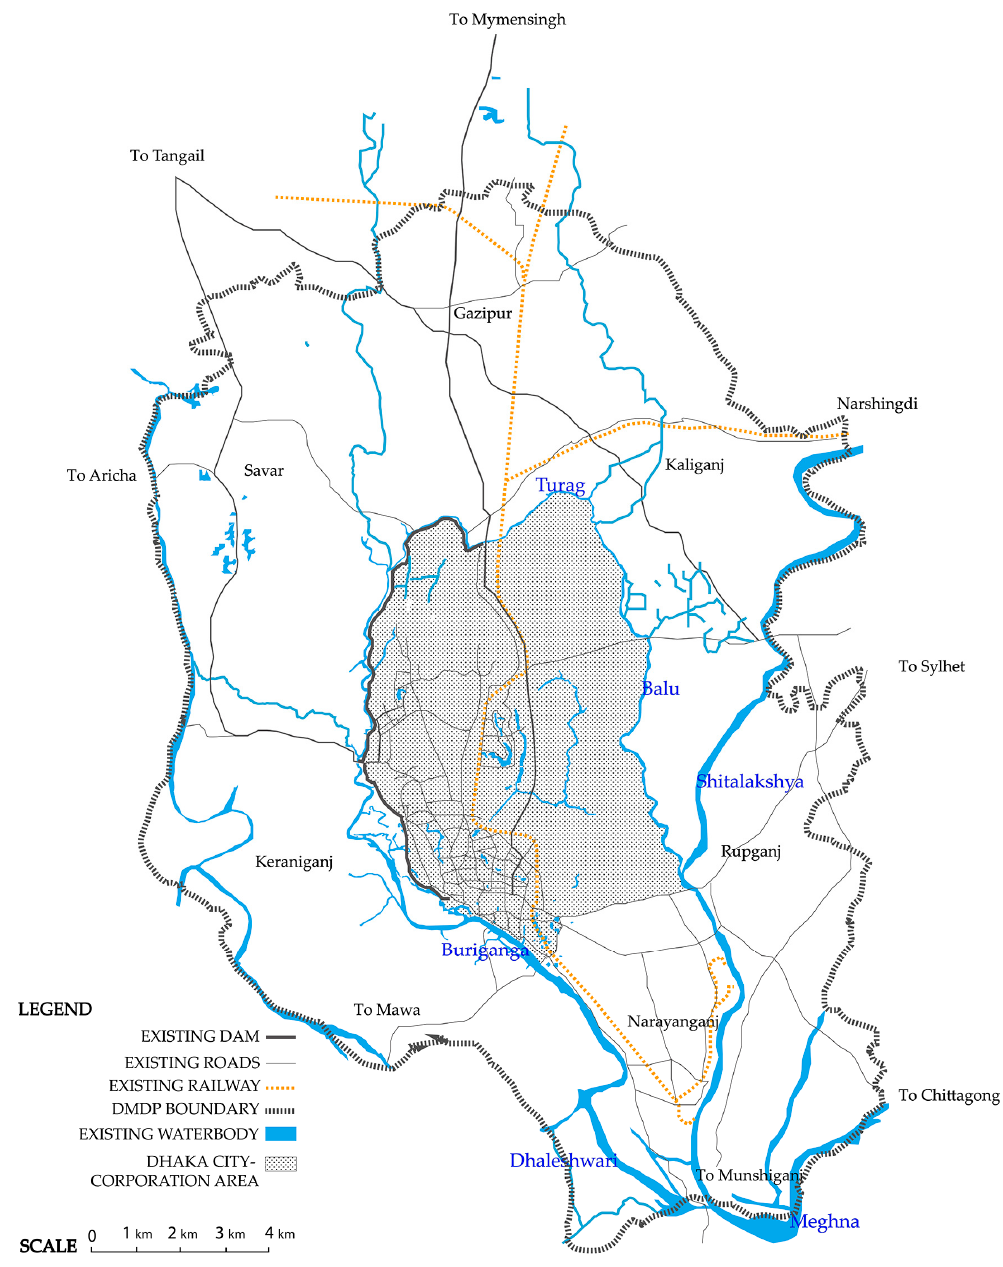
Figure 1. Location of Dhaka at the territorial scale, at the confluence of three major rivers.